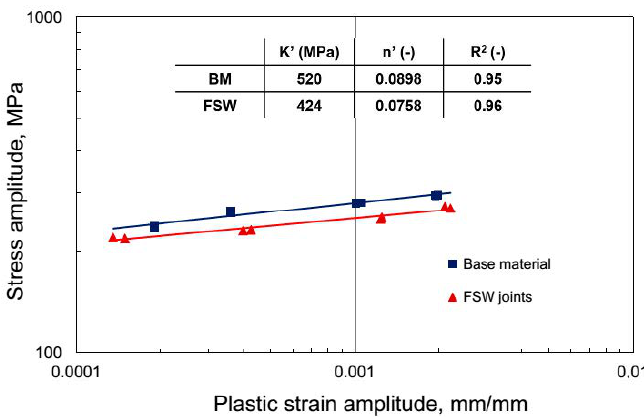
Figure 9. Stress amplitude versus plastic strain amplitude behavior.